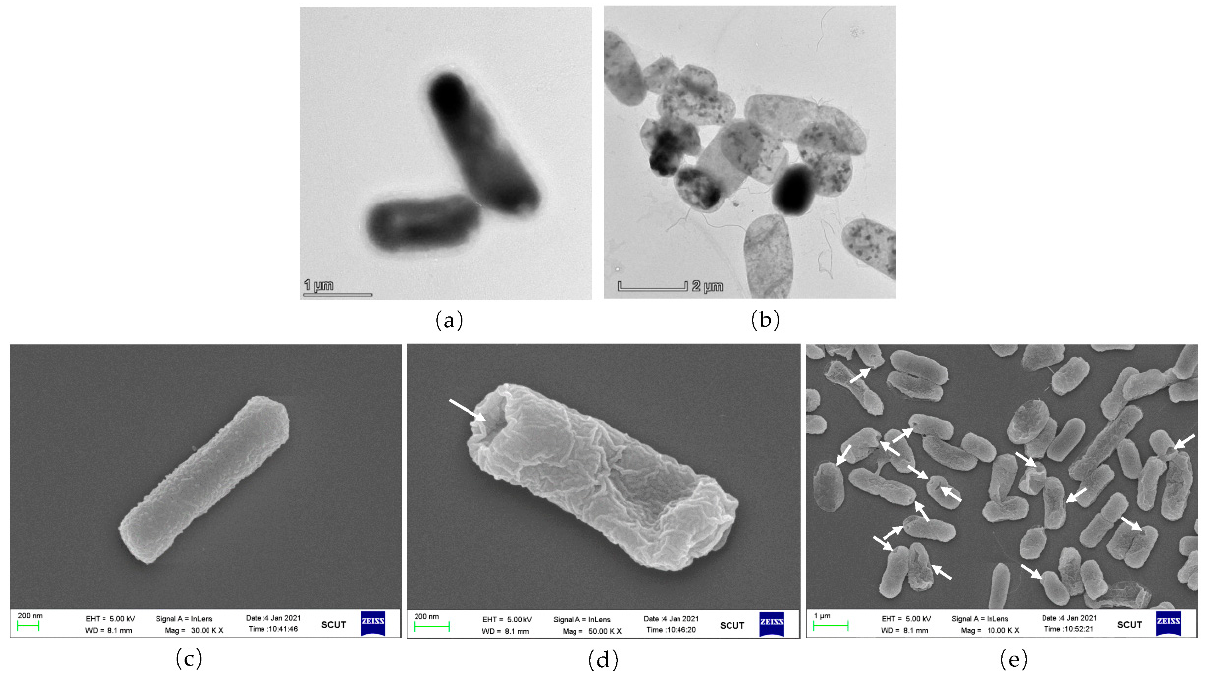
Figure 3. Morphology of A-BGs by TEM and SEM. ( a ) TEM image of the control EcN/ ∆ tnaA ::T7 RNAP/pLysS-LOA bacteria. ( b ) TEM image of A-BGs after IPTG induction. ( c ) SEM image of control EcN/ ∆ tnaA ::T7 RNAP/pLysS-LOA bacteria. ( d , e ) SEM images of a single A-BG and multiple ghosts at lower resolution. The white arrows show the transmembrane tunnels in the bacteria.